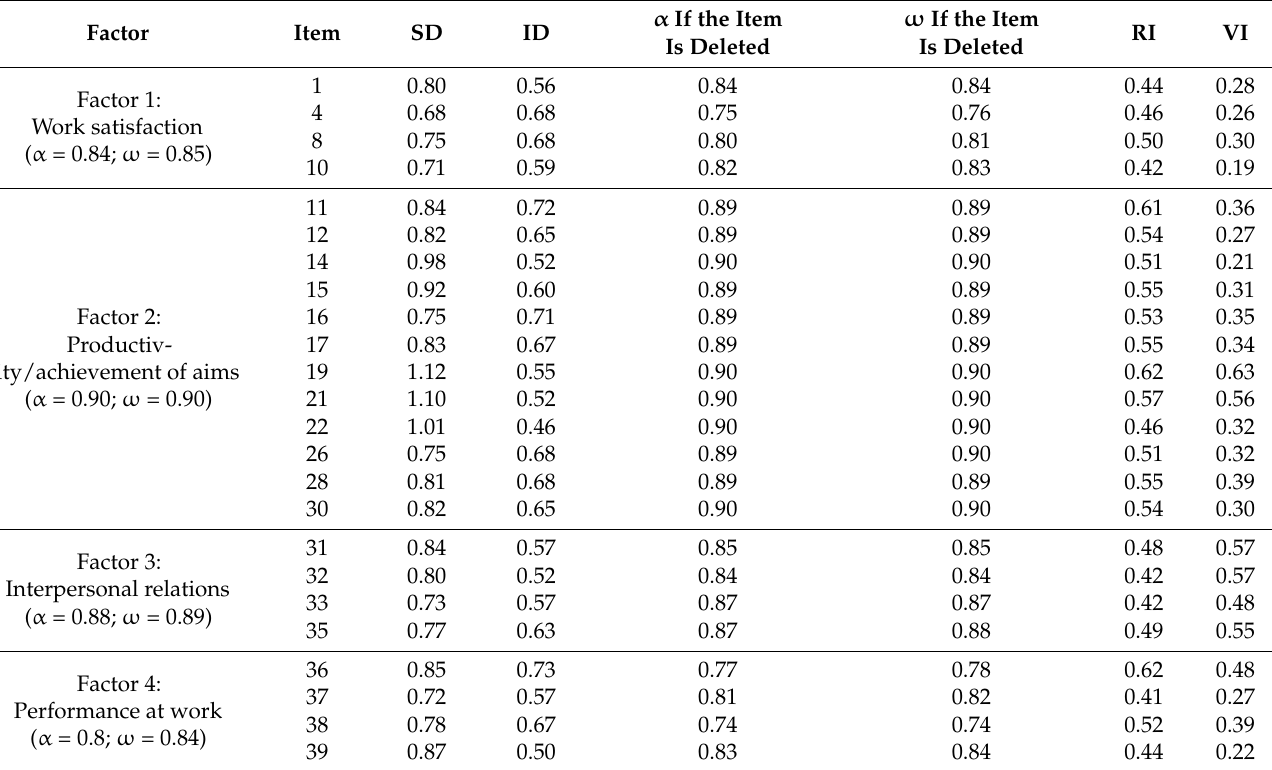
Table 4. Descriptive statistical indices for the items of each